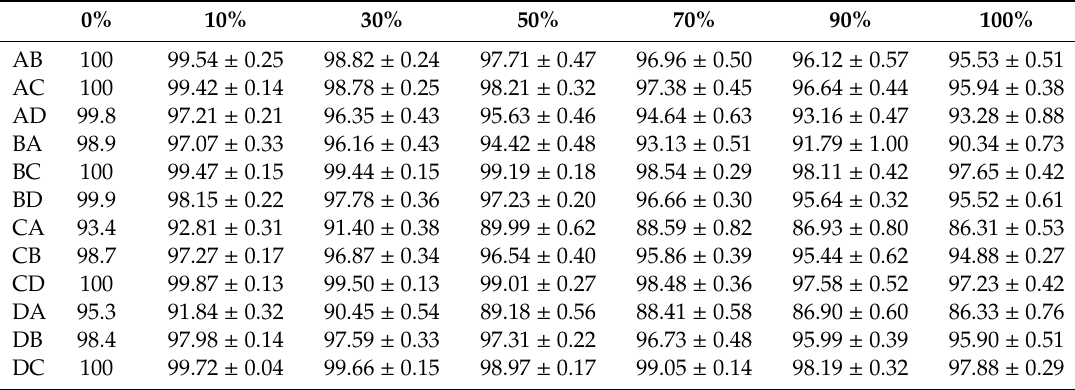
Table 11. Comparison of the transfer-learning ability of the proposed algorithm in terms of noise